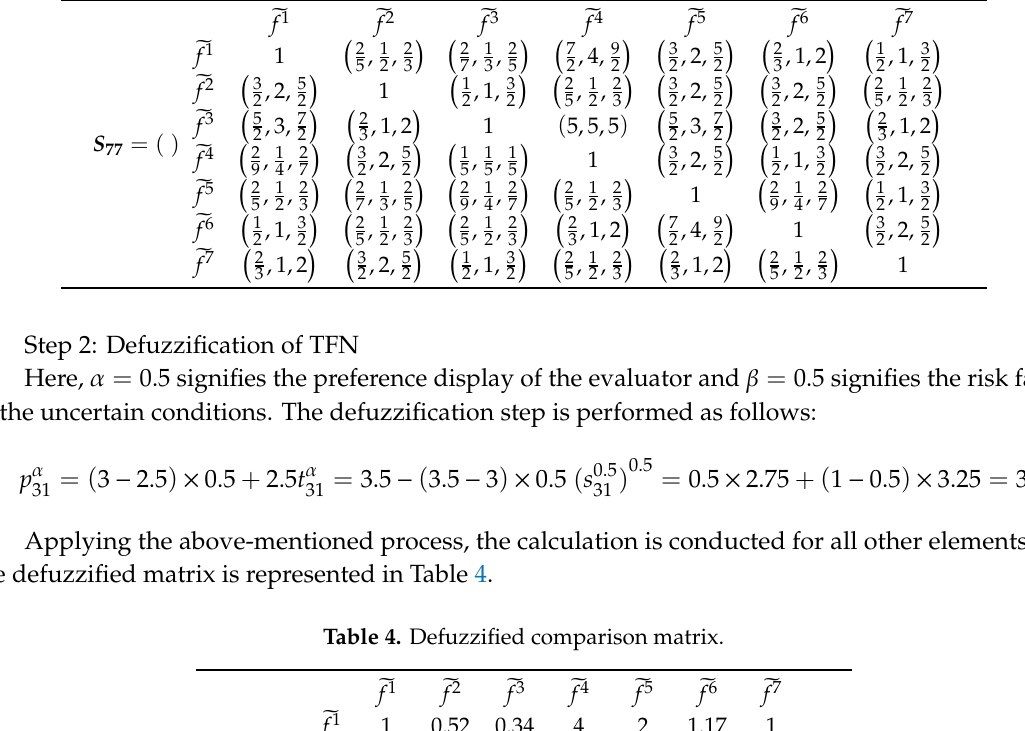
Table 3. Construction of the comparison matrix with respect to factors using Table 1.